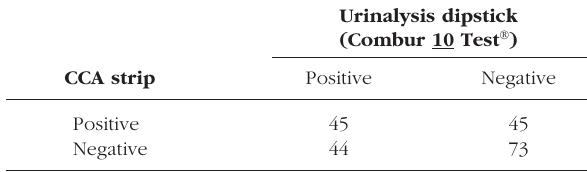
Table III. – Diagnostic performance of CCA strip compared with Uri- nalysis dipstick (Combur 10 Test ® ) for the diagnosis of S. haema- tobium in Hassoba Elementary school, Afar,